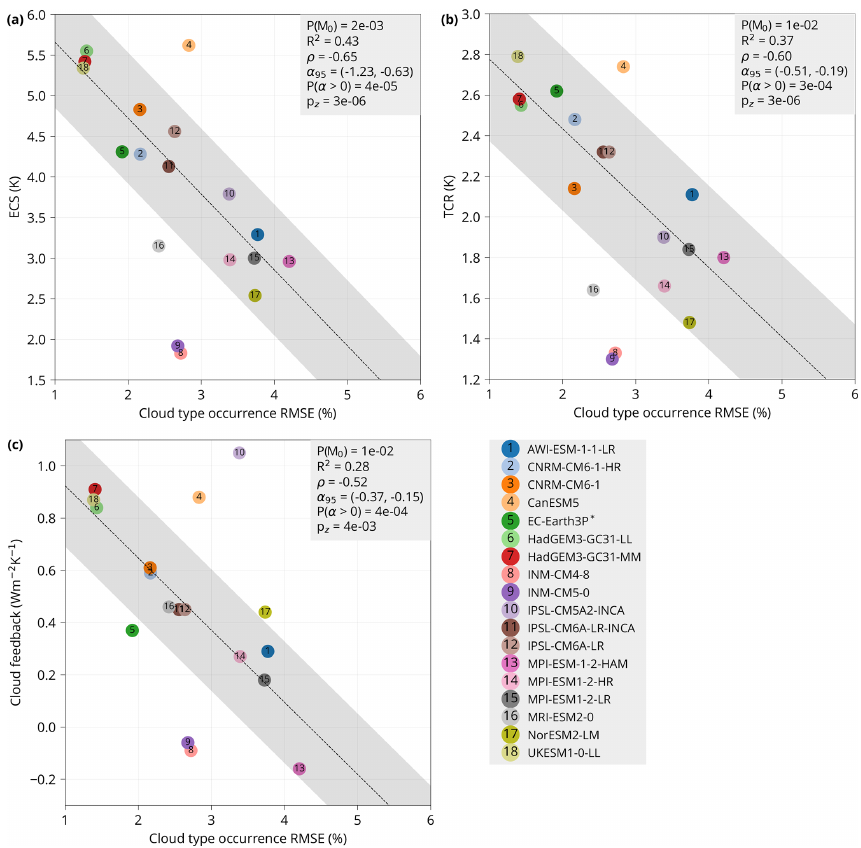
Figure 11. (a) Dependence of ECS, (b) transient climate response (TCR) and (c) climate feedback of CMIP6 models on the model total cloud type root mean square error (RMSE) relative to CERES, calculated from the geographical distribution (as in Fig. 6). The points are calculated from the ANN for 27 cloud types. Confidence bands represent the 68% range. Linear regression is calculated using Bayesian simulation assuming a Cauchy error distribution (Appendix A). Shown is also the probability of the null hypothesis model P ( M 0 ) (explained in Sect. 4.6), the coefficient of determination ( R 2 ), the correlation coefficient ( ρ ), the 95% confidence interval of the slope ( α 95 ) of the linear regression, the probability that the slope is greater than zero P ( α > 0) and the p value of a z test ( p z ) for the difference in the means of two groups of models in the bottom 50% and top 50% of ECS (a) , TCR (b) and cloud feedback (c) . For some models, marked with “*”, ECS was not available and was taken from a related available model (see Table